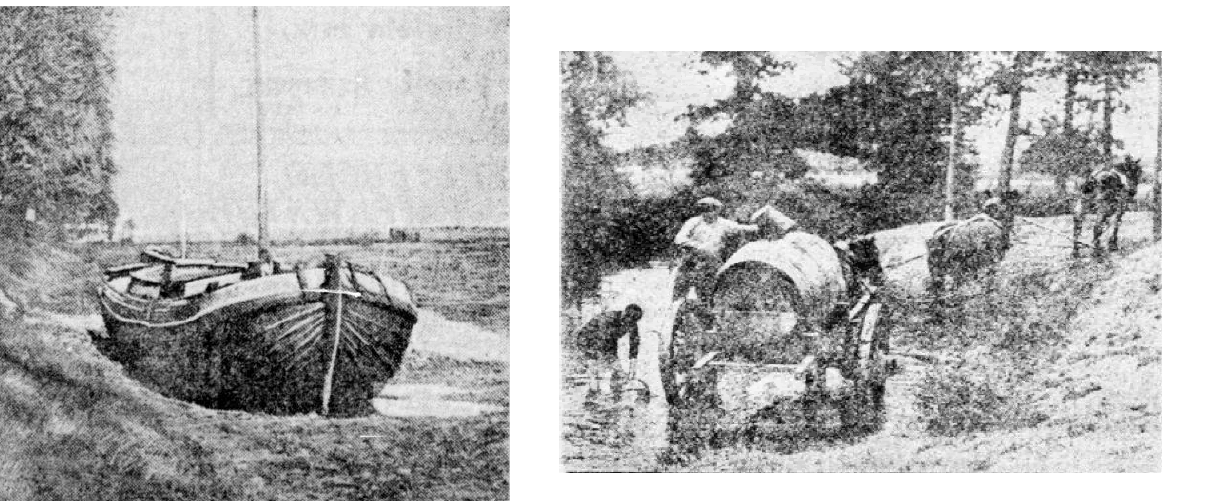
Figure A5. Photograph from the Dutch newspaper De Telegraaf , 14 August 1921. The original caption is “The drought in Zuid- Limburg. Fetching water from the Geul near Valkenburg. Water is sold for 25cents a bucket or for two-and-a-half guilder coins per cask and finds eager buyers.”